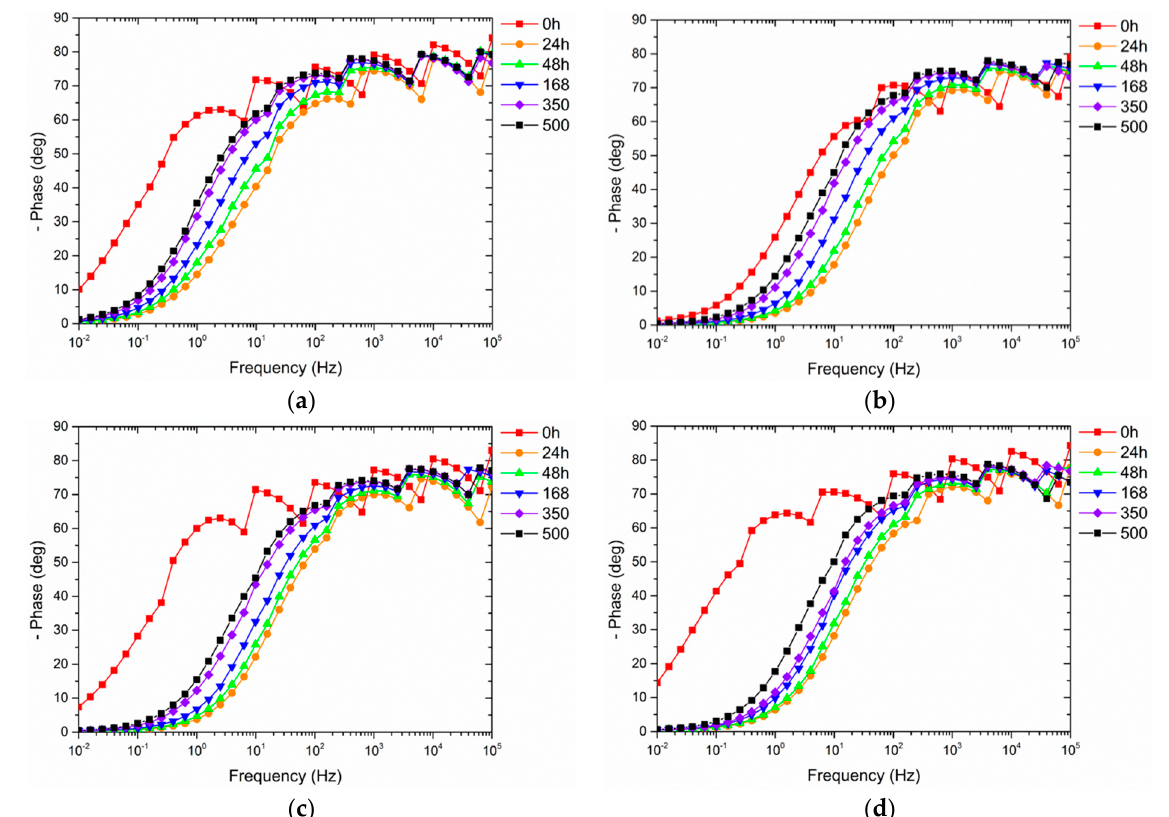
Figure 10. Bode phase spectra evolution with time of ( a ) sample G0, ( b ) sample G1, ( c ) sample G2 and ( d ) sample G3.